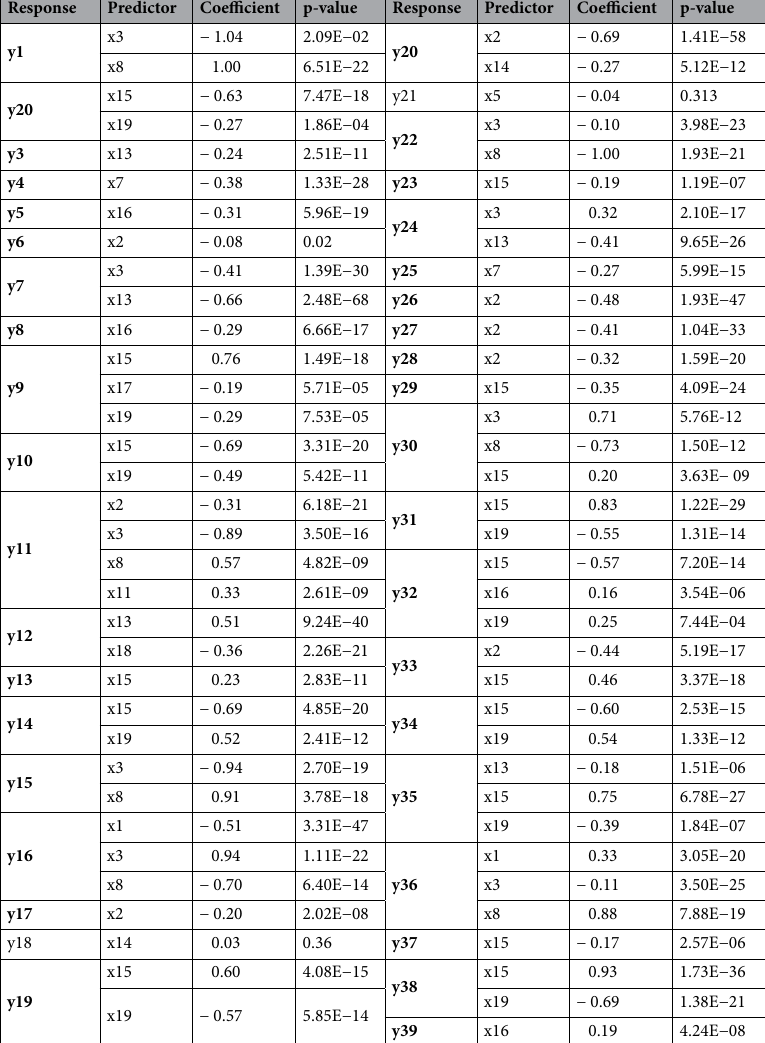
Table 3. Regression results. Significant modules are in bold.